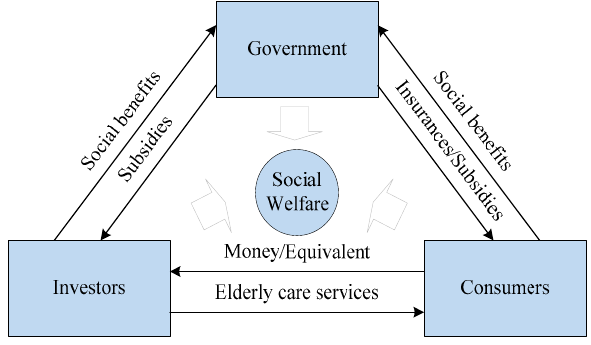
Figure 2. Relationships among stakeholders in the ECM.